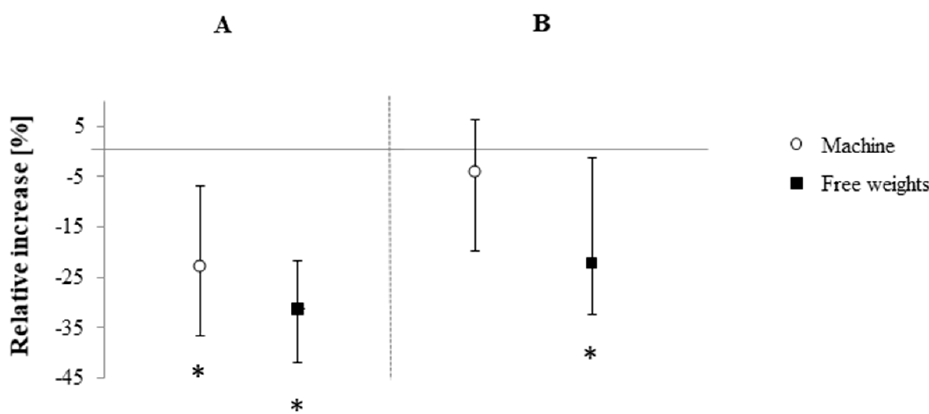
Figure 1. Relative changes in the two parts ( A , B ) of the Trail Making test (TMT) following free-weight and